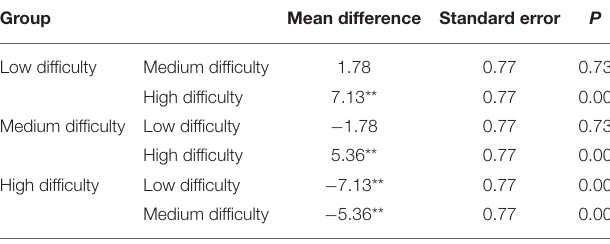
TABLE 5 | Effect of the training intervention on the jumping motor performance among children of different ages.